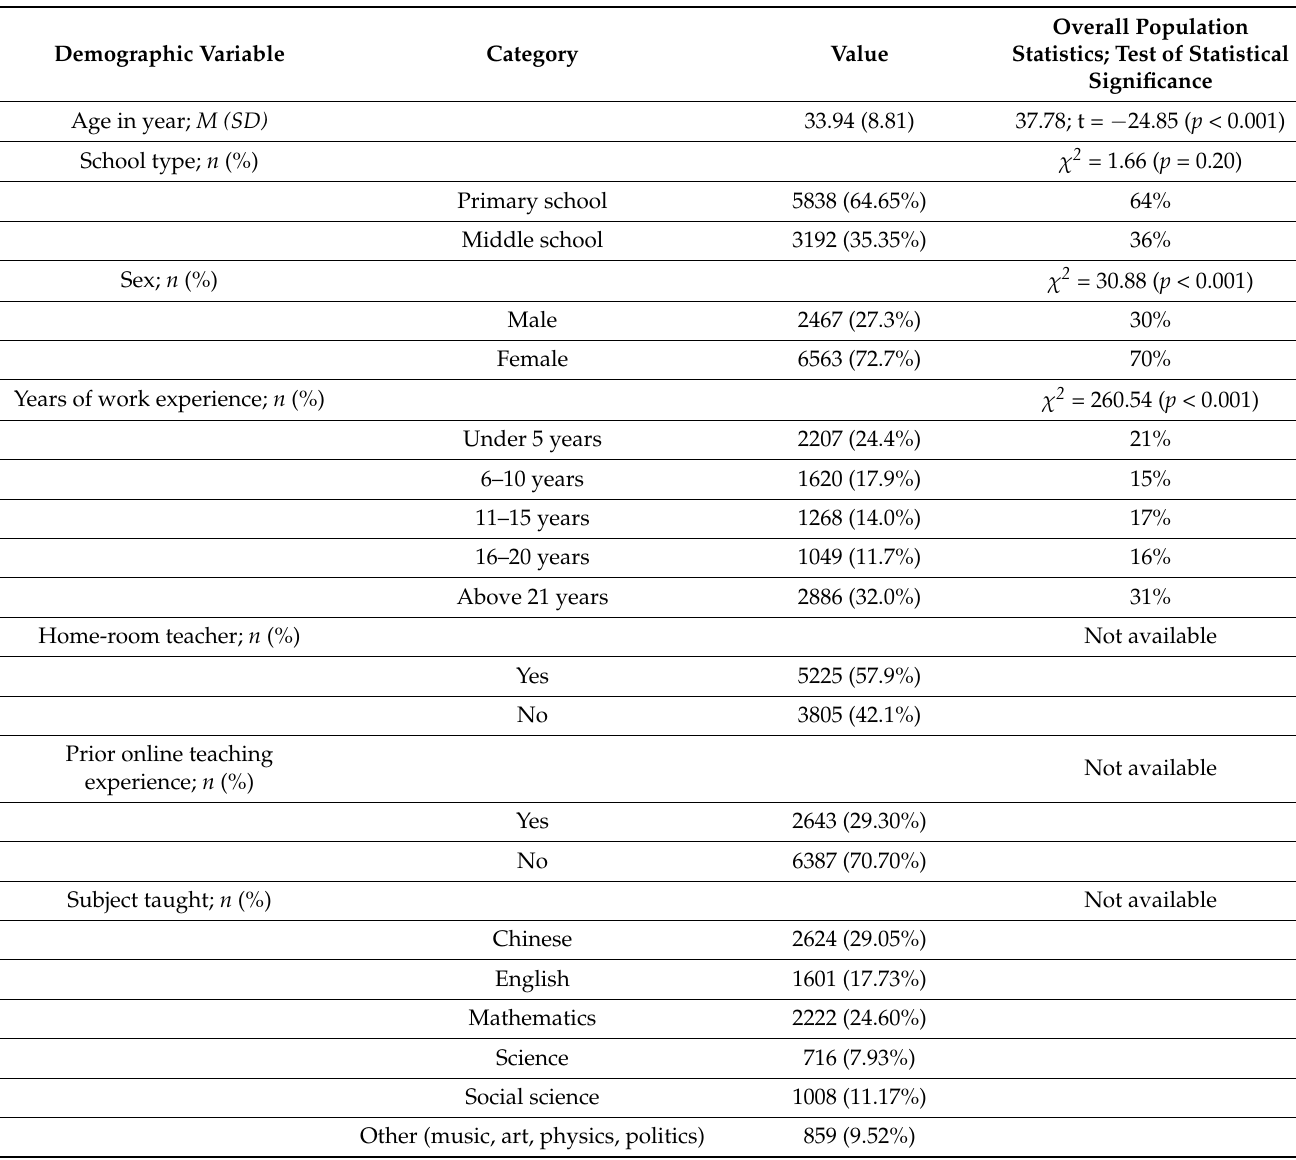
Table 1. Key characteristics of the participants of the study ( N =